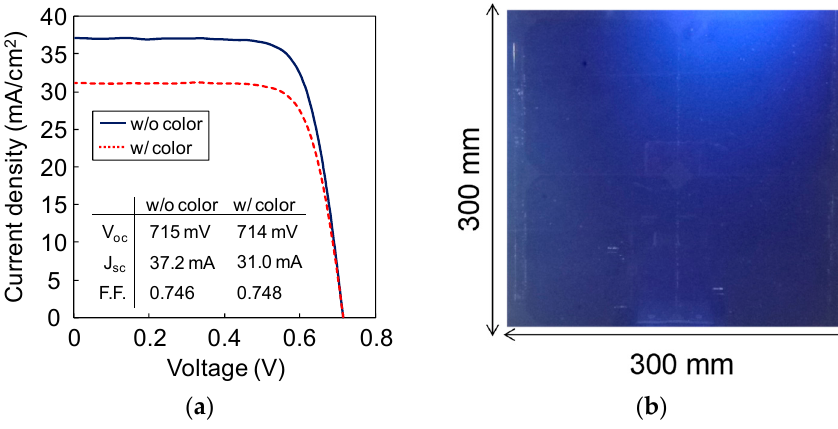
Figure 6. ( a ) Measured solar module characteristics with and without the dilute mica pigment with 10% PWC. ( b ) Photo of the fabricated solar module with 10% PWC dilute mica pigment.